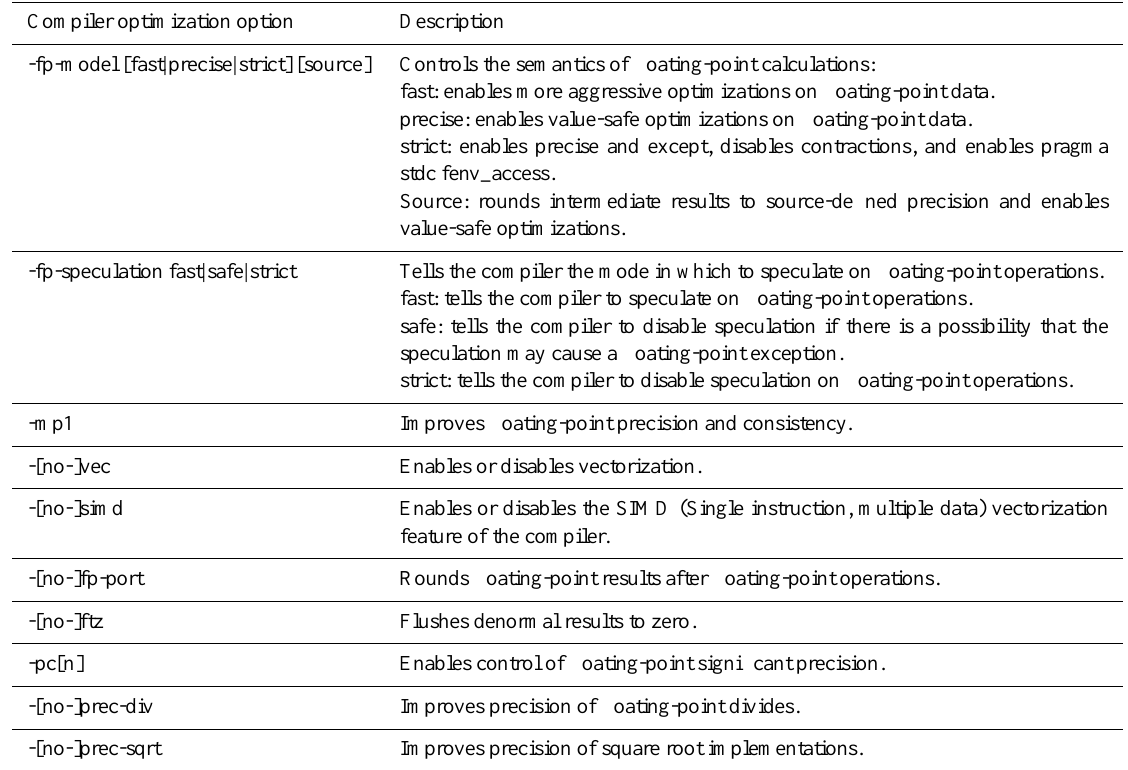
Table 3. Intel compiler optimization options that may impact the precision of floating-point calculation. They are common to the compiler versions listed in Table 2.